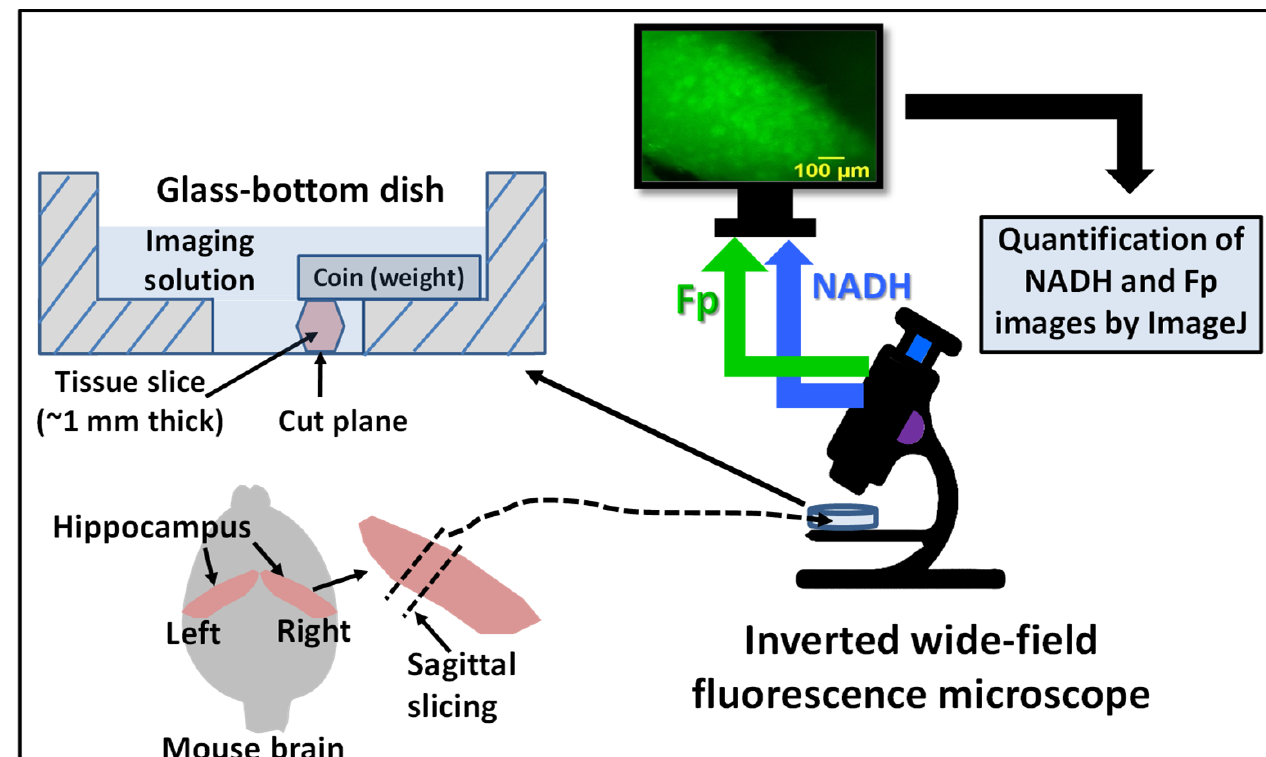
Figure 1. The schematic for ex vivo optical redox imaging of hippocampal slice. Approximately 1 mm thick sagittally cut hippocampal section from a freshly dissected right hippocampus was placed in a 35 mm glass-bottom dish containing imaging solution immediately after slicing. Before imaging, the hippocampal slice was immobilized by a penny coin, with majority of the coin weight resting on the plastic part of the dish bottom. The cut plane was tile-imaged with an inverted wide-field fluorescence microscope equipped with proper optical filters, a 4 × objective lens with a field of view of 2343 × 1849 µ m 2 . The raw images of NADH and Fp were processed and quantified using ImageJ, and subsequently underwent further analyses (see Materials and Methods for